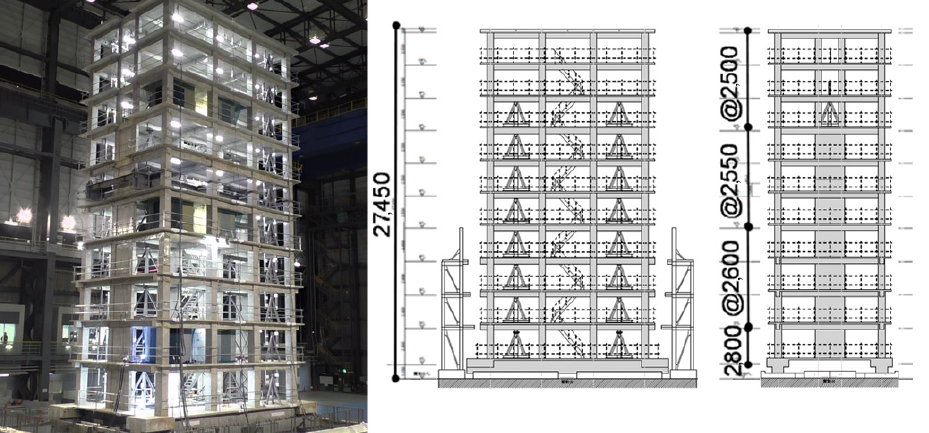
Figure 11. The photograph and schematic of the full-scale